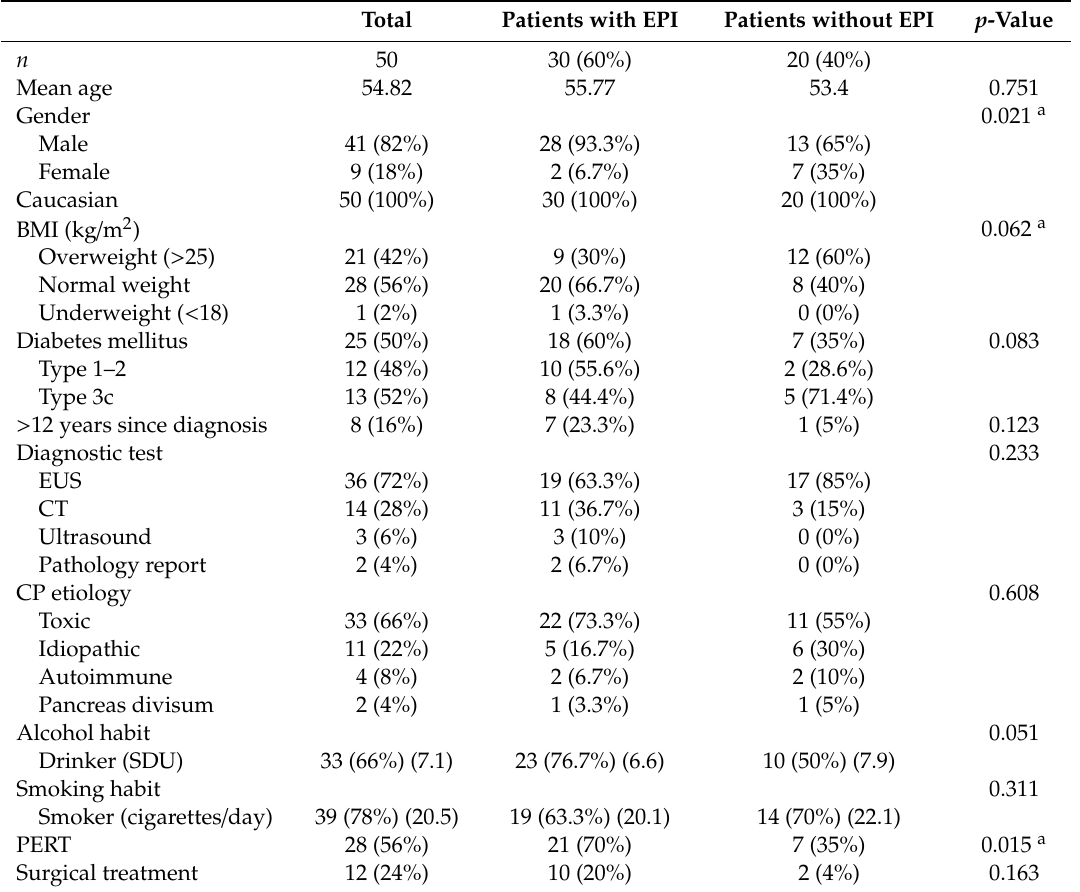
Table 1. Patient characteristics ( n = 50).